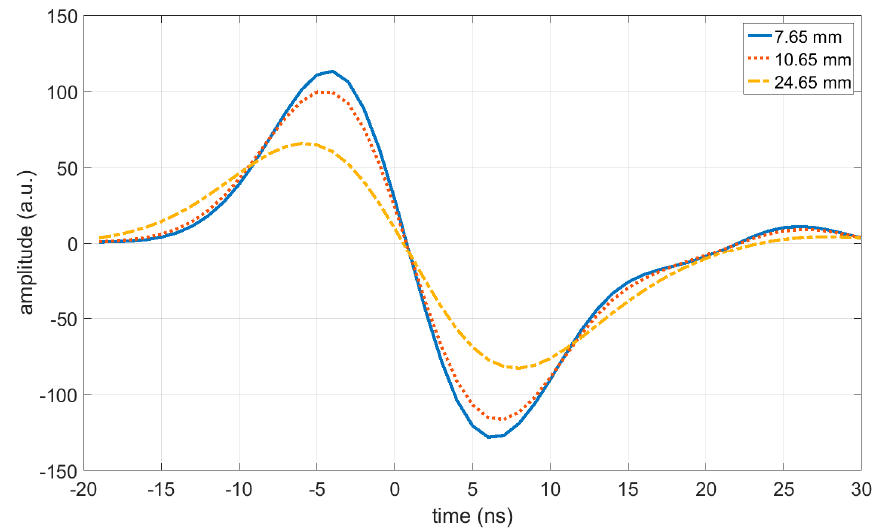
Figure 2. Measured acoustic pressure as a function of time at a distance r of 7.65 mm, 10.65 mm, and 24.65 mm. A total of 32 measurements were averaged to get a signal-to-noise ratio (SNR) of approximately 570 instead of 100 for single measurements. The time scale was shifted for each signal, which allows plotting all of the signals with the same time scale.